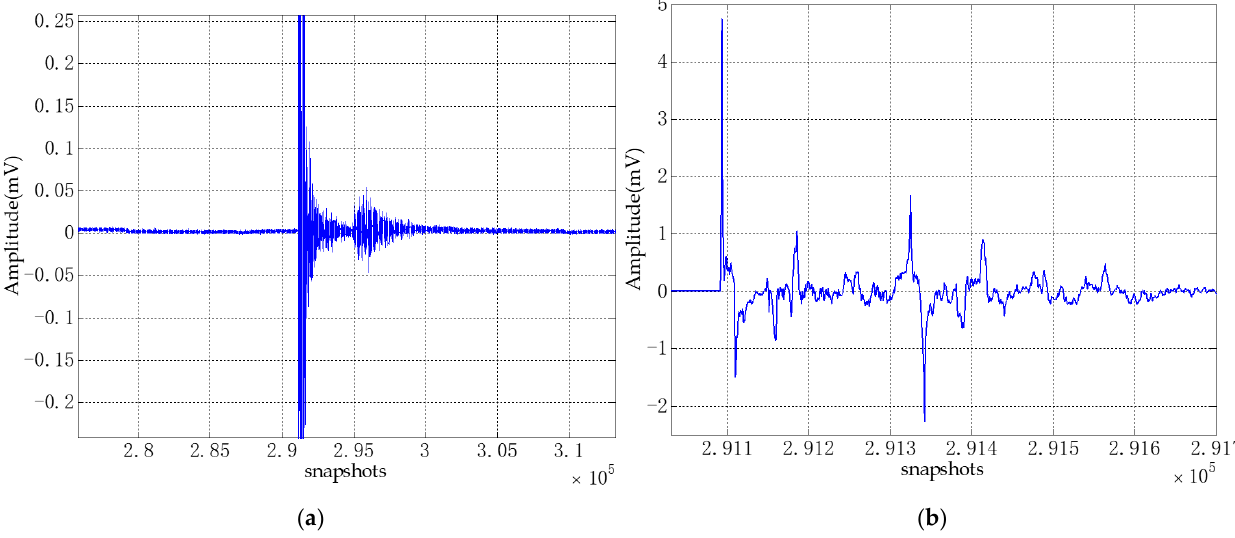
Figure 21. The part of original signal. ( a ) The signal near the shock wave, ( b ) Partial enlargement of the highest peak shock wave signal.